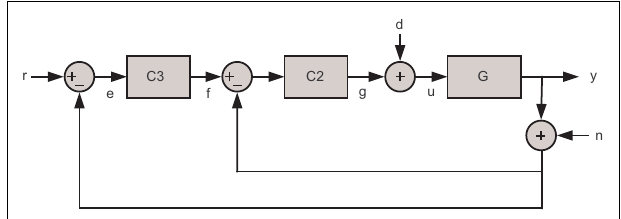
FIGURE 5 | x -axis tracking control system with the damping controller in regulator form C 2 ( s ) and the tracking controller C 3 ( s ) . The signal w is the disturbance input and n is the sensor